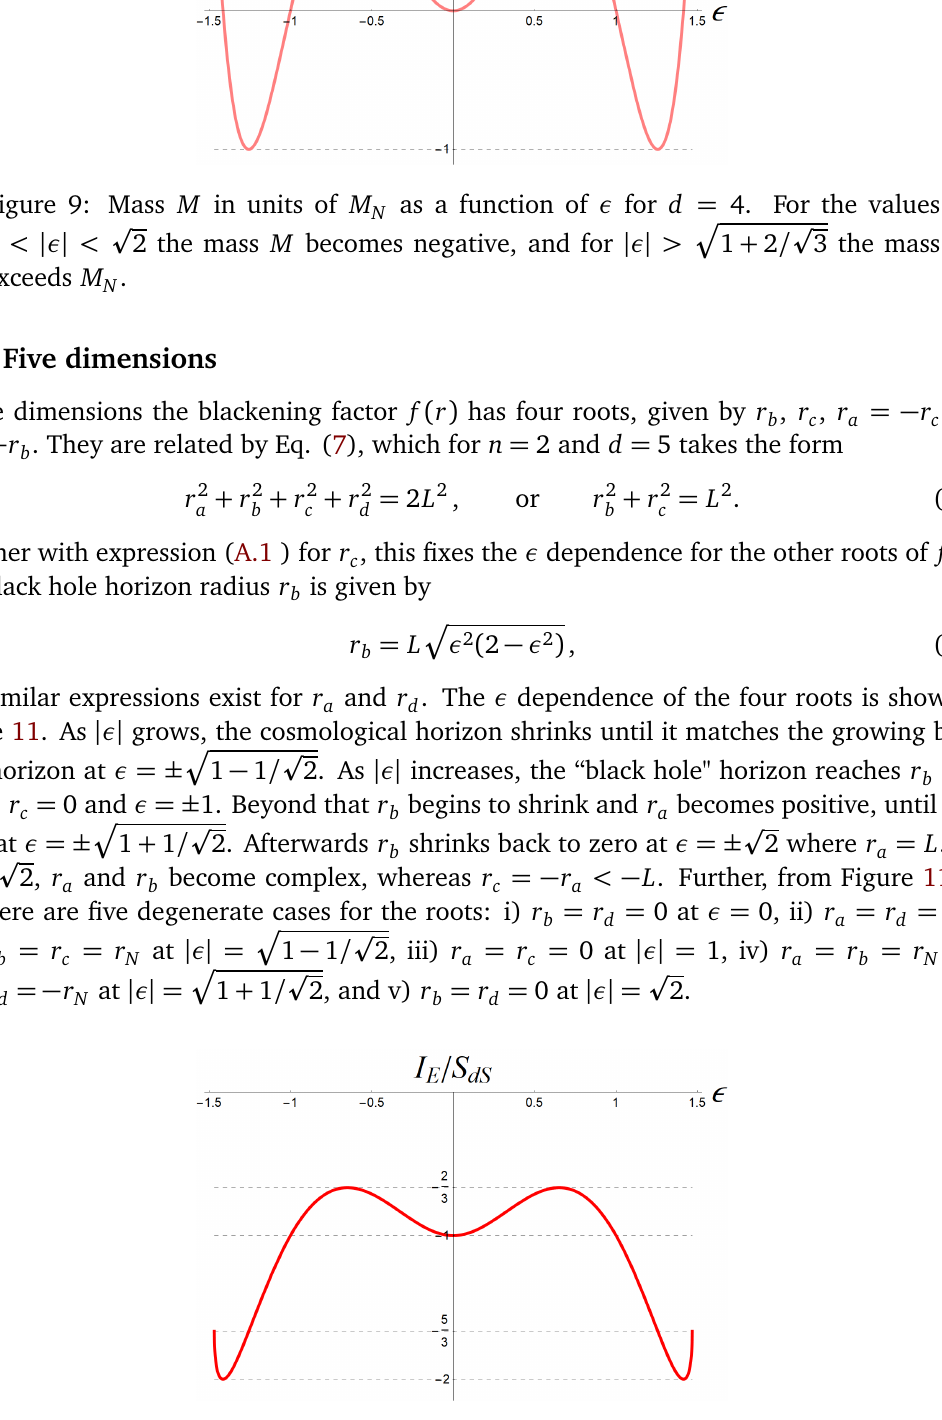
of SdS in units of S as a function of ε for d = 4. E dS (cid:112) 2 for which M =